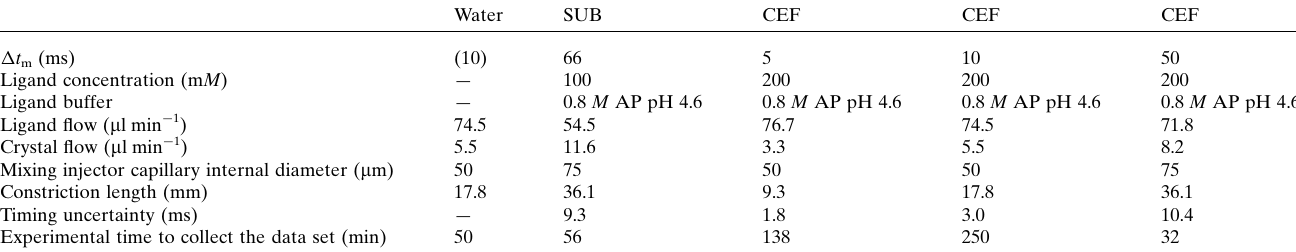
Table 2 Parameters for the mix-and-inject experiments. Concentrations of ceftriaxone (CEF) and sulbactam (SUB) are shown as were flowed through the outer capillary line of the mixing injectors. Time delays are achieved after mixing in a constriction as per Calvey et al.